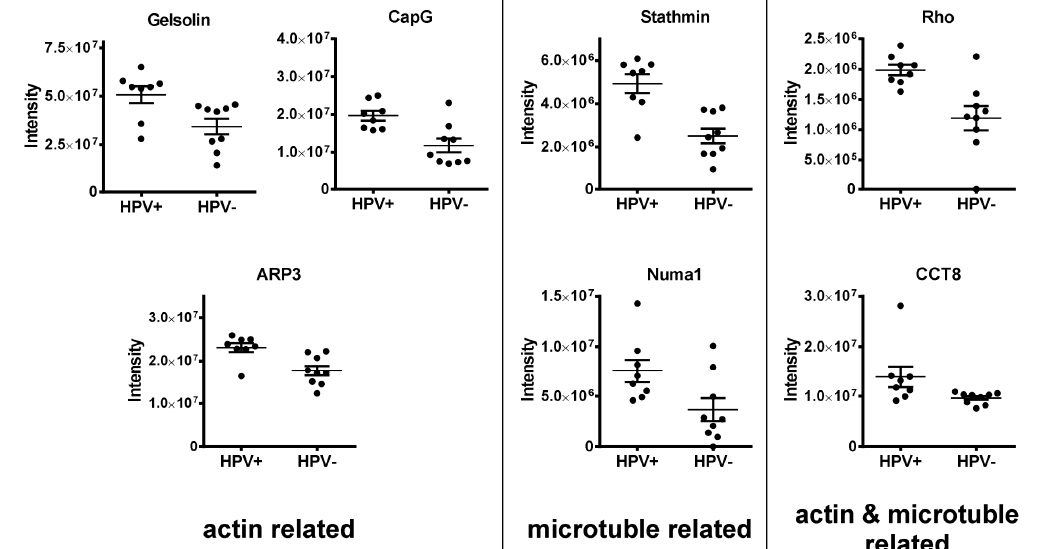
Figure 5. Cytoskeleton regulators. Depicted are the individual expression levels of cytoskeleton organizing and regulating proteins with differential expression in HPV-positive and HPV-negative OPSCC as assessed by LC–MS/MS intensity values.